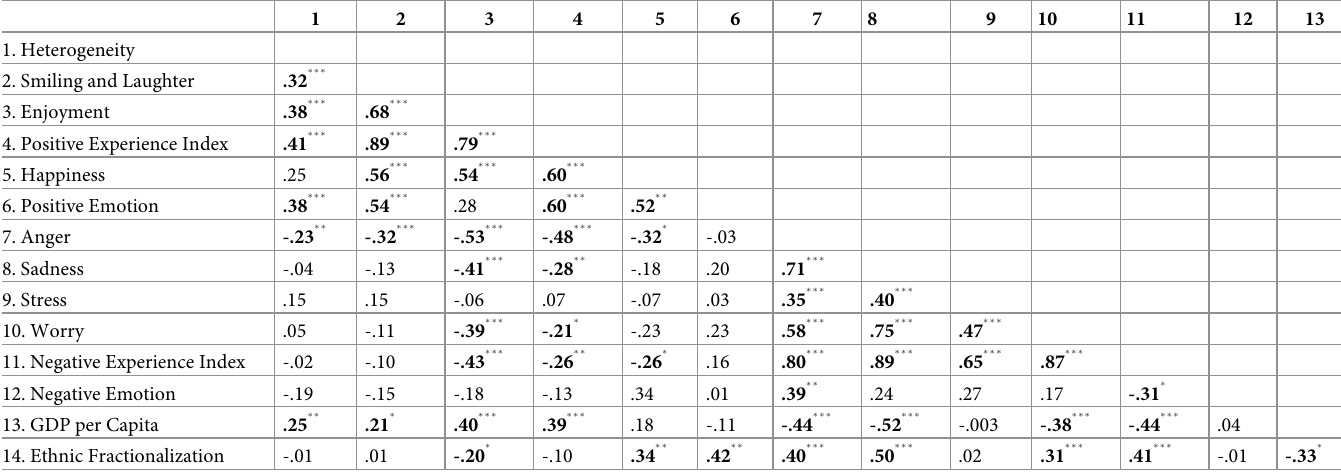
Table 1. Correlations between variables in Study